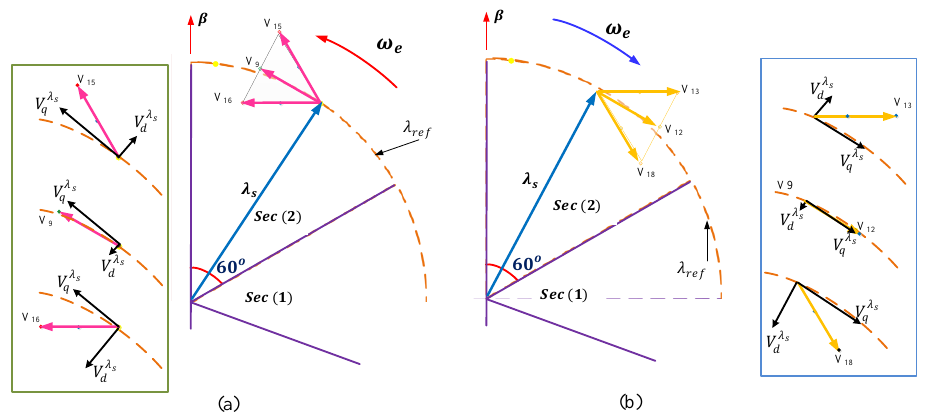
Figure 5. Illustration for the optimal candidate VVs for Sec (2) at ( a ) anticlockwise speed direction and ( b ) clockwise speed direction. and ( b ) clockwise speed direction.